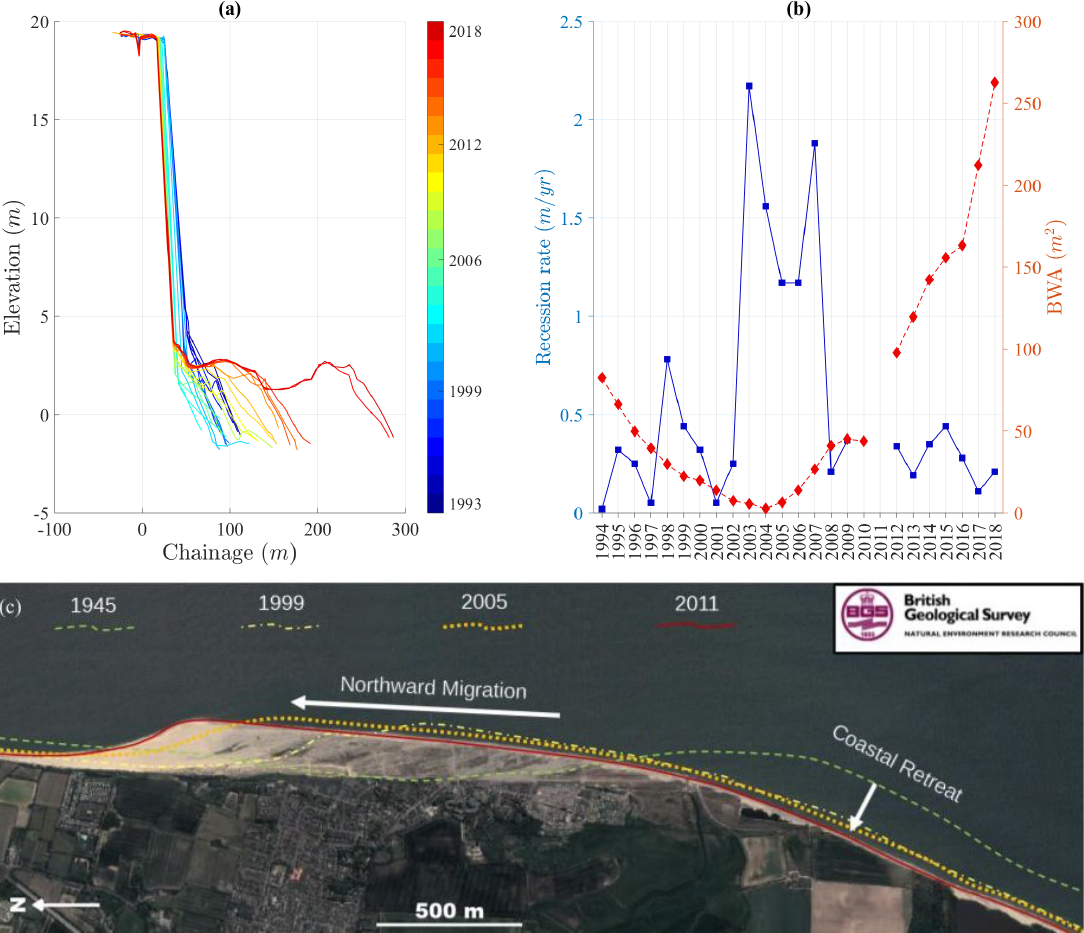
Figure 8. ( a ) Annual profile data plot, SWE7 Suffolk. ( b ) BWA (square marked, blue solid line) and cliff top recession rate (diamond marked, dashed red line) calculated for every year for the profile SWE7. The missing points are due to incomplete data from years 2010–2011. ( c ) Benacre Ness northward